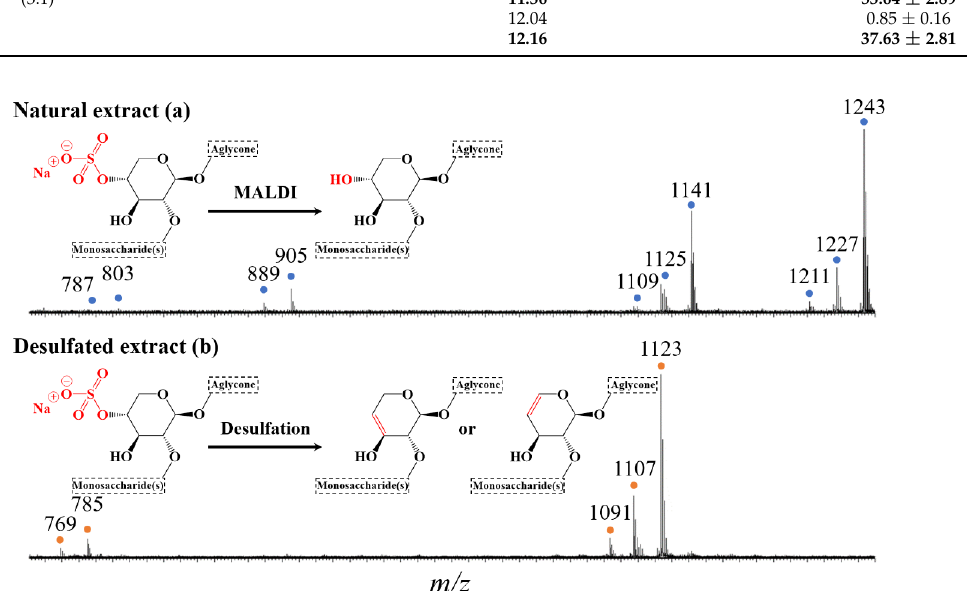
Figure 3. Mass spectrometry analysis of two different saponin extracts: ( a ) the purified saponin extract with detection of sulfated 4-sugar saponin ions, desulfated 4-sugar saponin ions, sulfated 2-sugar saponin ions and desulfated 2-sugar saponin ions; and ( b ) the microwave-assisted alkaline desulfation (pH 14—100 °C—5 min) reaction products with 4-sugar desulfated saponin ions and 2-sugar desulfated saponin ions.